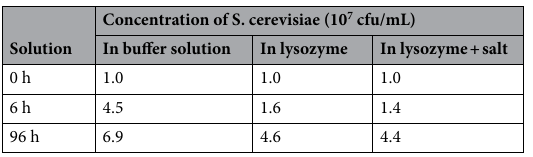
Table 1. The concentrations of S. cerevisiae in the buffer solution, the lysozyme solution and the crystallisation solution (lysozyme with